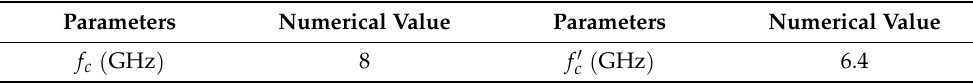
Table 4. Anti-jamming simulation parameters in azimuth